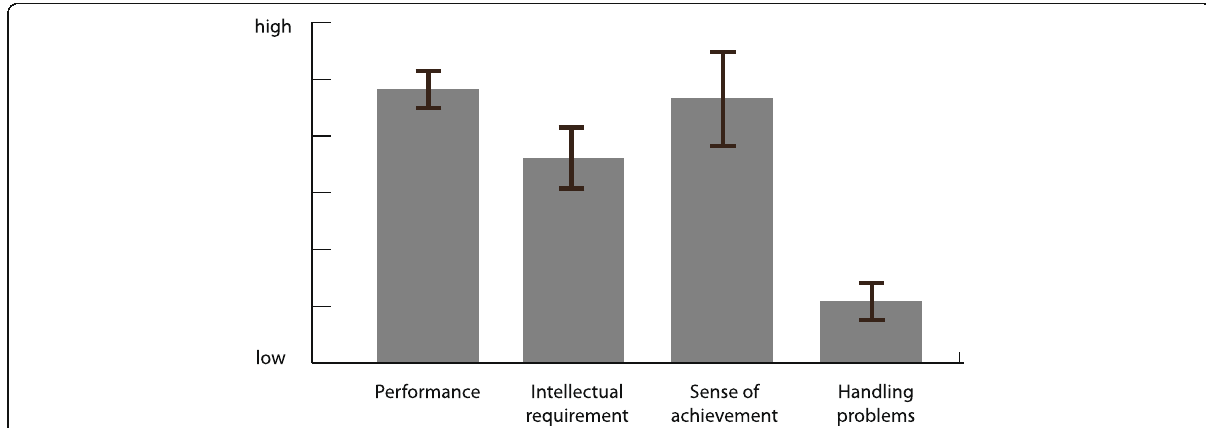
Fig. 13 Subjective assessment of the participants as a result of the questionnaire (mean values with 95% confidence